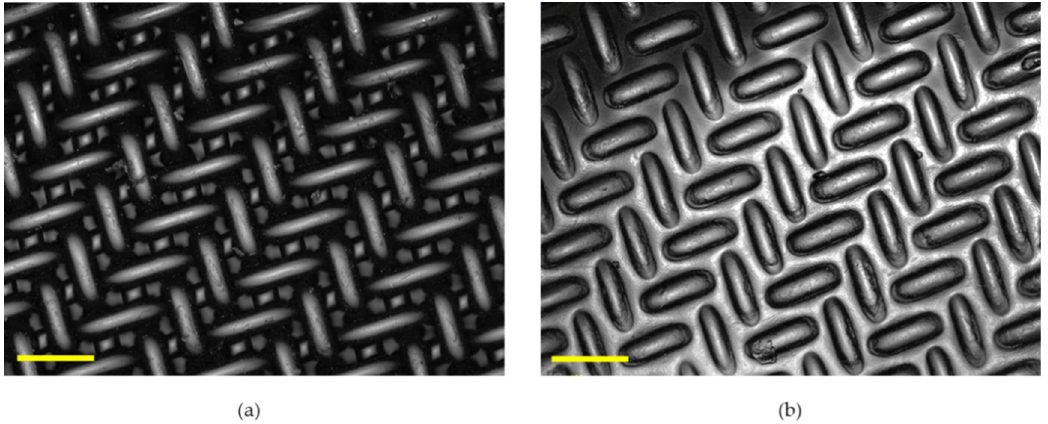
Figure 3. ( a ) Woven mesh and ( b ) patterned membrane images produced by LEXT using the 20× objective. The average dimensions of the mesh features are 130 ± 2 (s.d.) μ m by 52 ± 3 μ m with average fiber height of 30 ± 2 μ m. The average end-to-end feature dimensions on the membrane are 100 ± 6 μ m by 34 ± 3 μ m, with average depth of 19 ± 2 μ m. The common scale bar for images is 100 μ m.